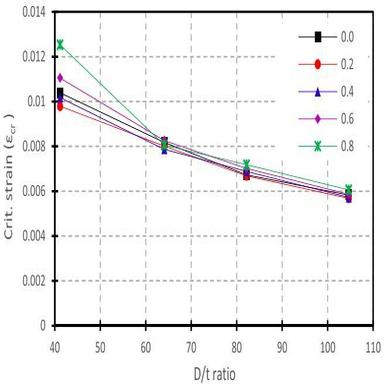
Plot of εcr vs. D/t ratio for X70 pipe (PL/US = 0.58).